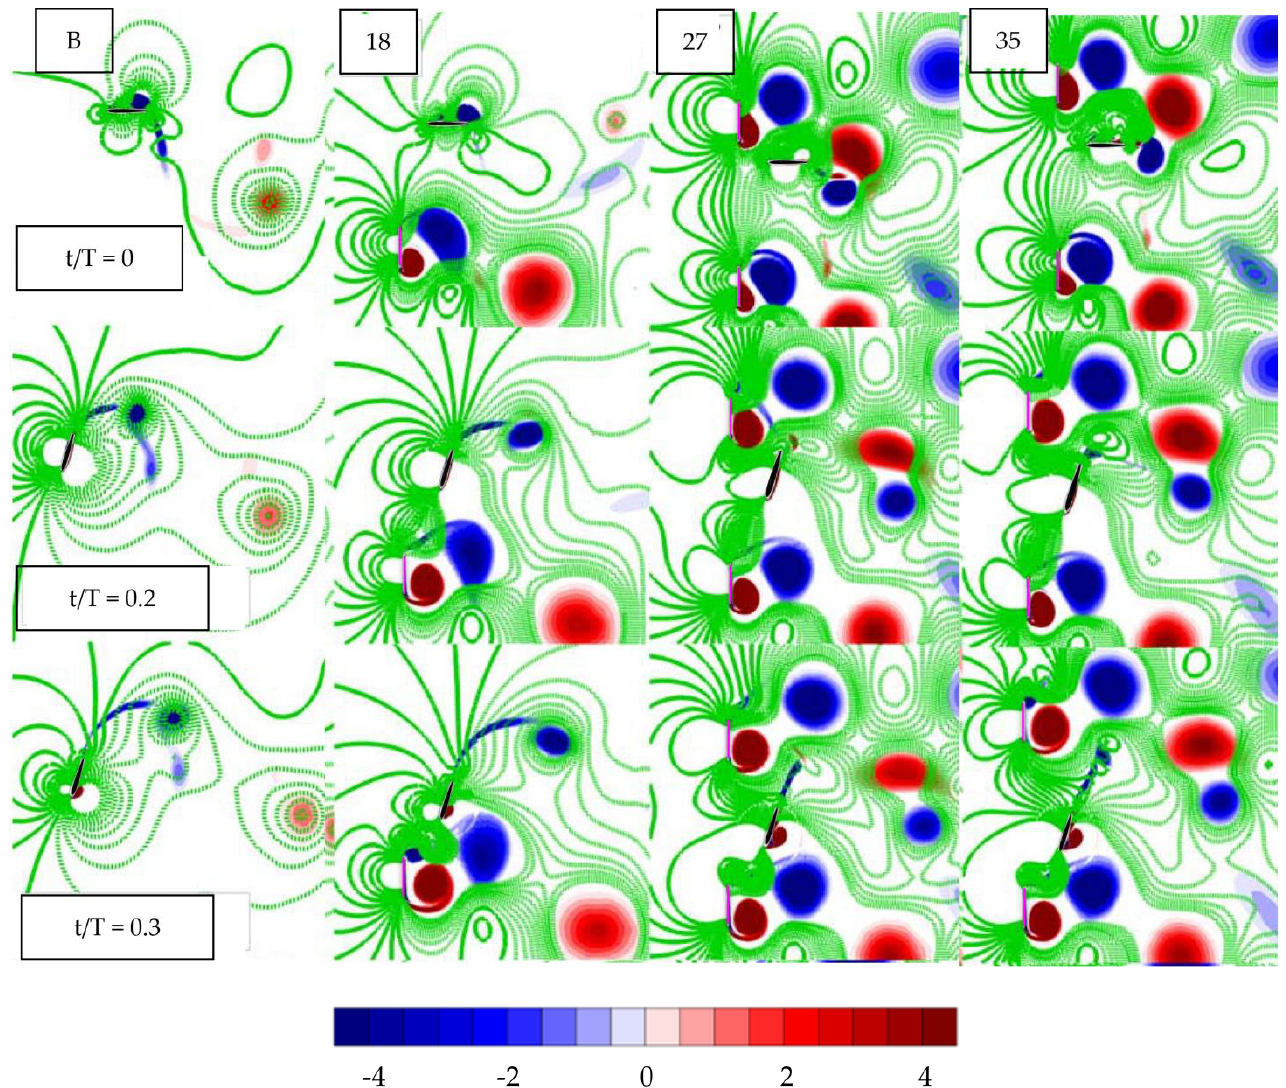
Figure 9. A comparison of the vortex structures and isolines of pressure of an oscillating hydrofoil equipped with a single/dual upstream deflector during downstroke (solid isolines: positive pressure; dashed isolines: negative pressure).